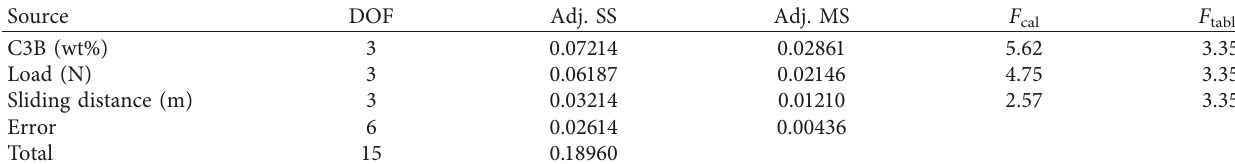
Table 7: ANOVA table for grey fuzzy